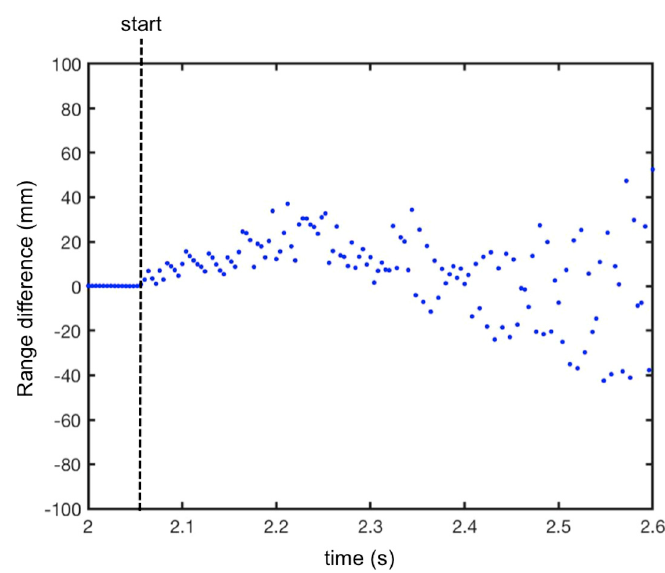
Figure 14. Difference between the effective range and the measured range with the Doppler correction during the fall.